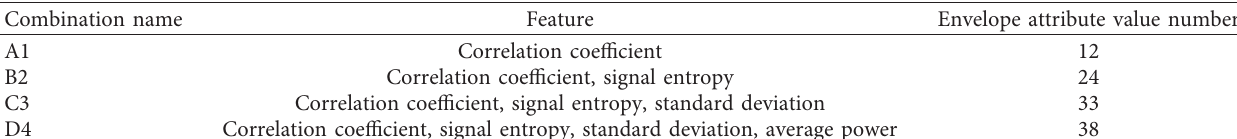
Table 2: Best feature combination.